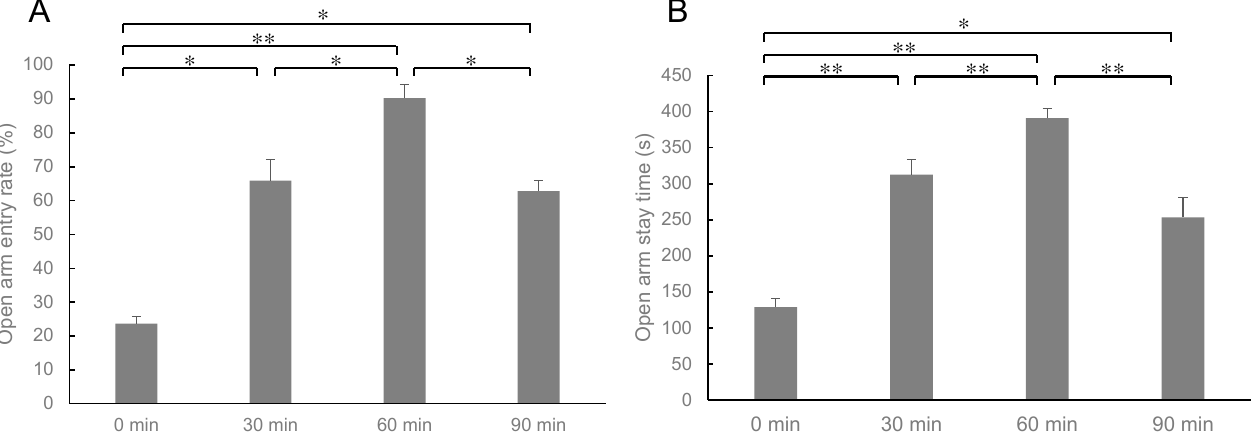
Figure 2. Elevated plus-maze test. ( A ) Open arm entry rate (%), ( B ) open arm stay time (s). Results represent mean ± SEM (n = 6). * p < 0.05, ** p < 0.01 (Two-way ANOVA followed by Tukey’s test or Student’s t -test).